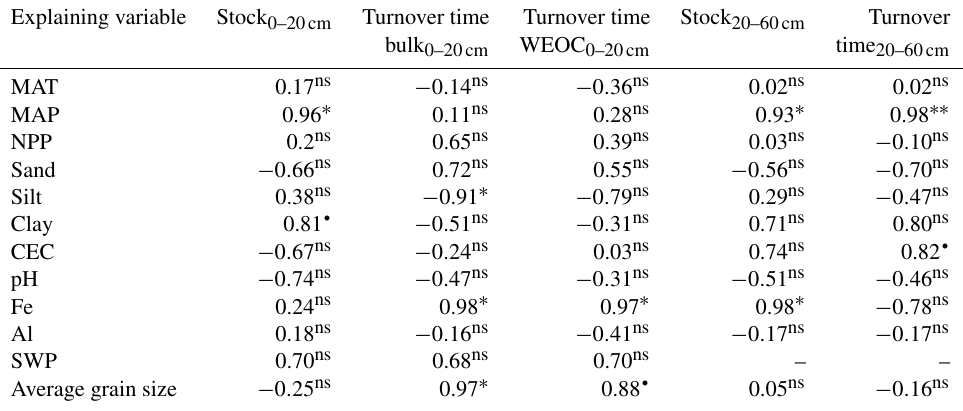
Table 4. Pearson correlations for averaged depth intervals for the topsoil (0–20cm, n = 5) and deep soil (20–60cm, n = 5). Significance (cid:113) is denoted with , ∗ , or ∗∗ for p values smaller than 0.1 (marginally significant) 0.05, and 0.005 (significant), respectively. Nonsignificant correlations are indicated by the superscript “ns”. SWP or soil water potential used are the median values at 15cm for each of these five sites (Von Arx et al., 2013). Water-extractable carbon is abbreviated to WEOC. Results indicate that no single climatic or textural factor consistently covaries with carbon stocks, or turnover